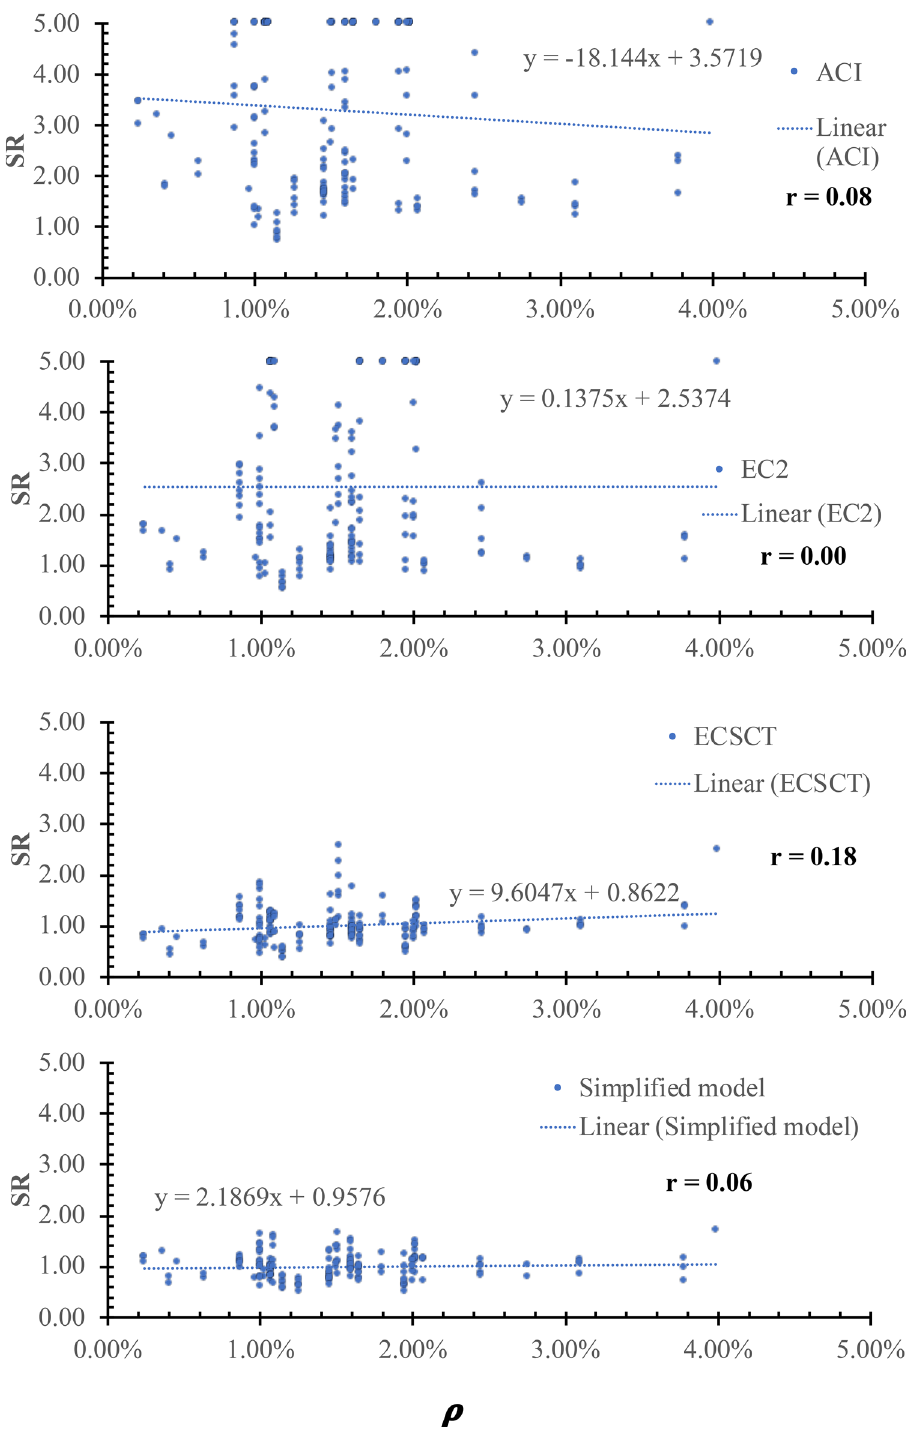
Figure 13. SR using various methods versus the ρ